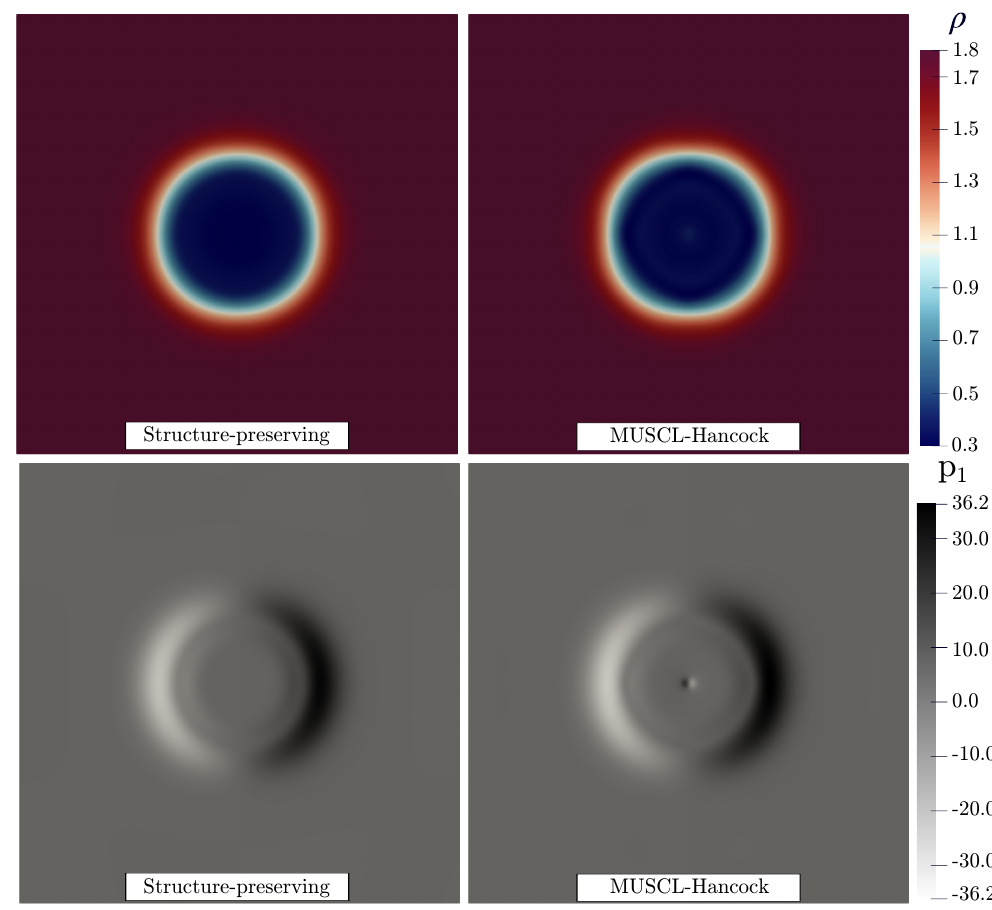
Figure 8. Comparison of the overall shape of the density field ρ (top) and the gradient field component p 1 (bottom) with both a curl-free discretization (left) and without (right). Results are shown for t = 2 on the 512 512 grid. ×